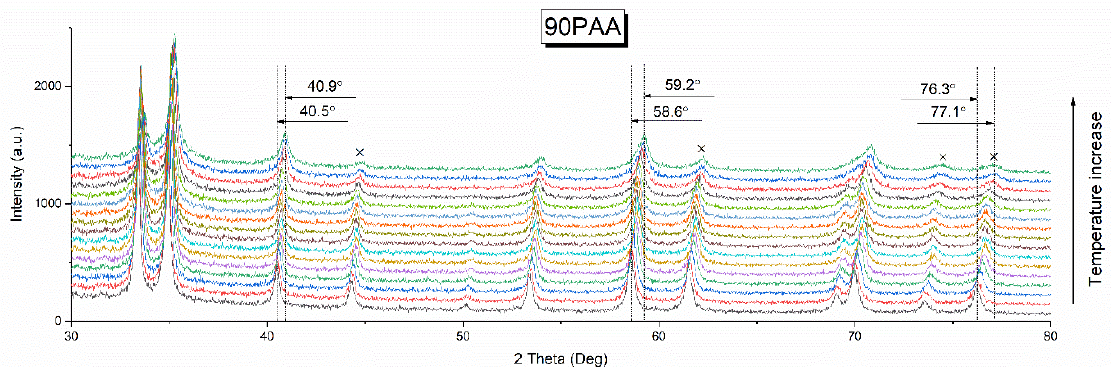
Figure 6. In situ X-ray patterns obtained for the 90PAA sample upon heating in the range 30–330 °C with steps of 10 °C.